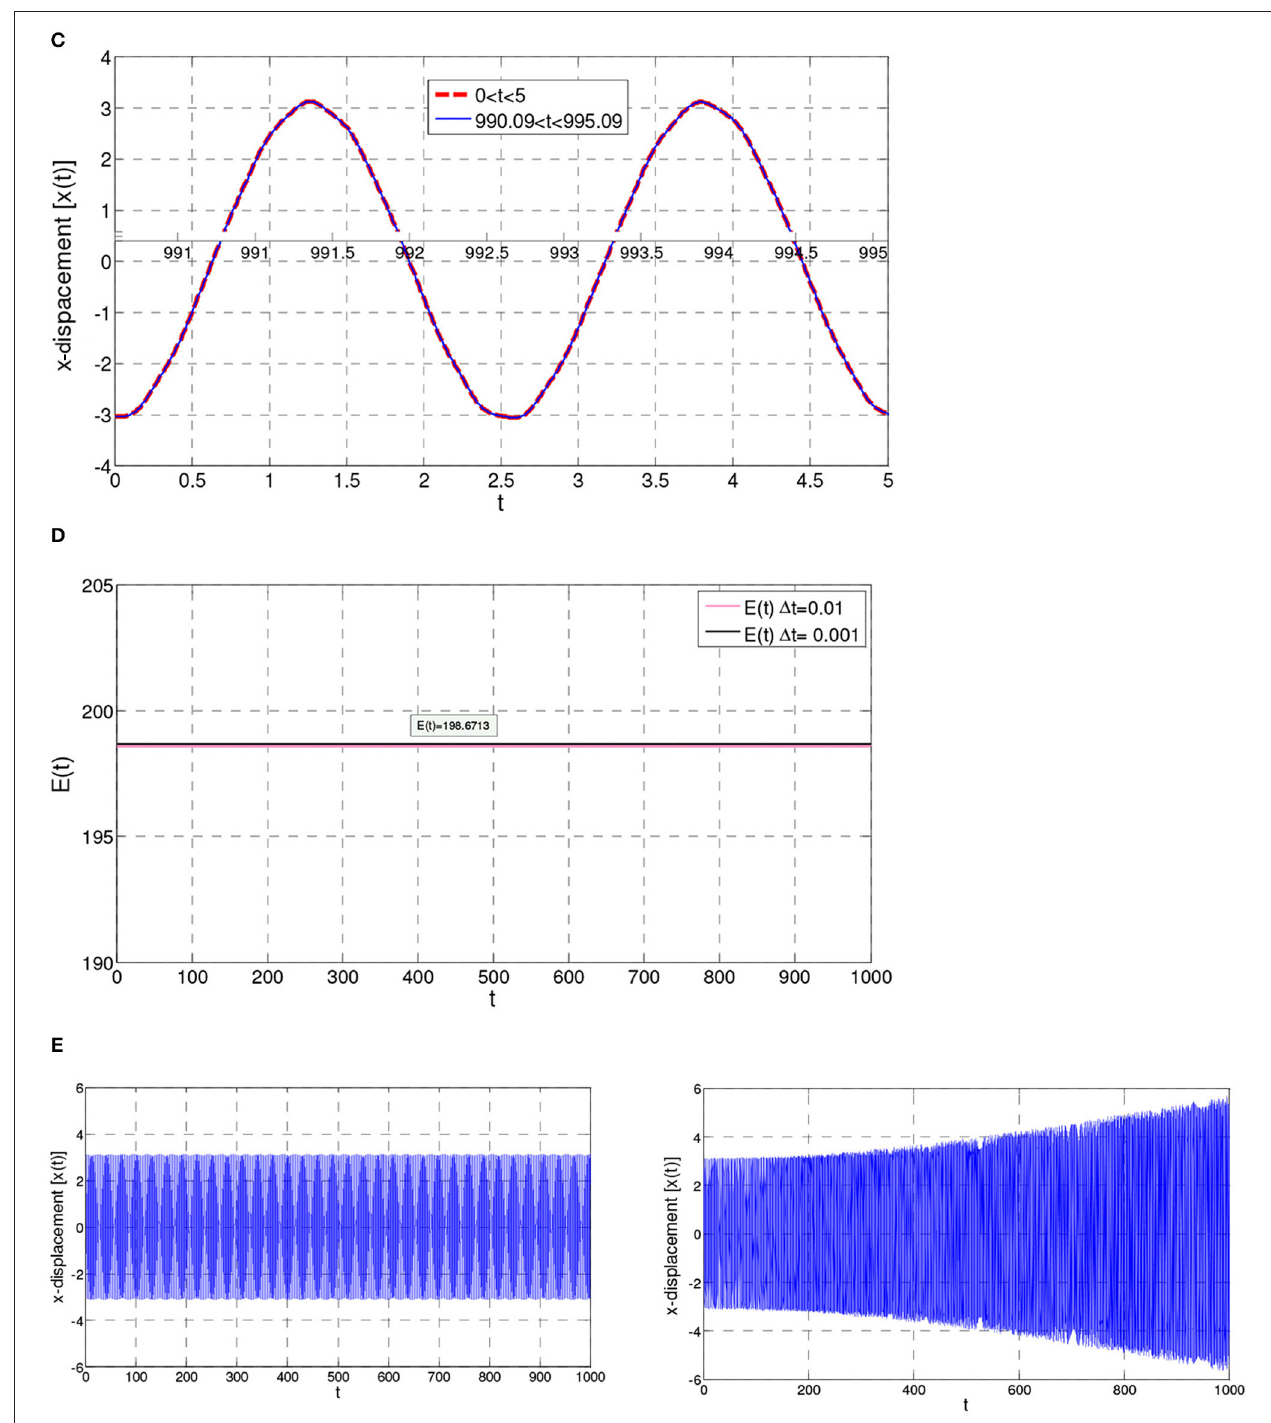
FIGURE 10 | (A) Elastic pendulum in Example 10. (B) Elastic pendulum using the present scheme with 1 t intervals 0 < t < 5 and 990.09 < t < 995.09 with 1 t with 1 t 0.01 and (right) Newmark’s trapezoidal rule with 1 t =